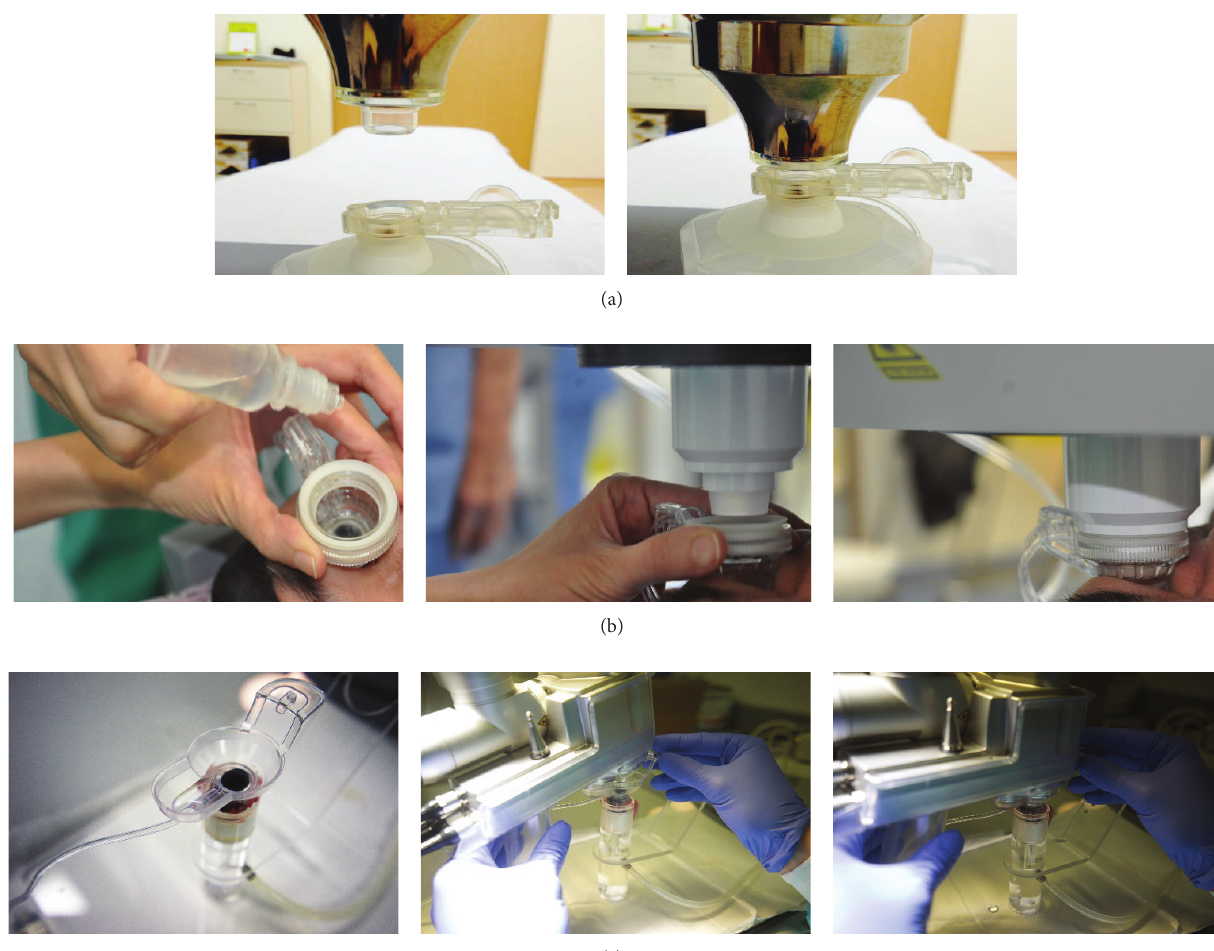
Figure 3: Overview of the docking processes with three femtosecond lasers. (a) Victus: suction ring applied to a sample and curved applanation cone attached to the laser head (left); laser head lowered onto the sample with vacuum on the suction ring (right). Note that, in the actual procedure, the ocular surface is moist. (b) Catalys: suction ring and application of the liquid interface (left); laser head lowered onto the ocular surface with vacuum on the suction ring (middle, right). (c) LDV Z8: suction ring and application of the liquid interface (left); manual docking of the laser handpiece with vacuum on the suction ring (middle, right). Note that surgeon’s gentle support of the laser handpiece is needed throughout the